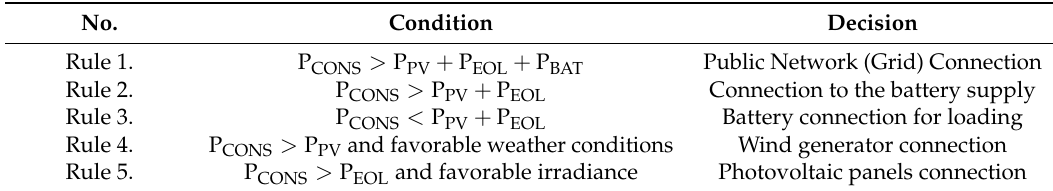
Table 1. The DSS decision rules.